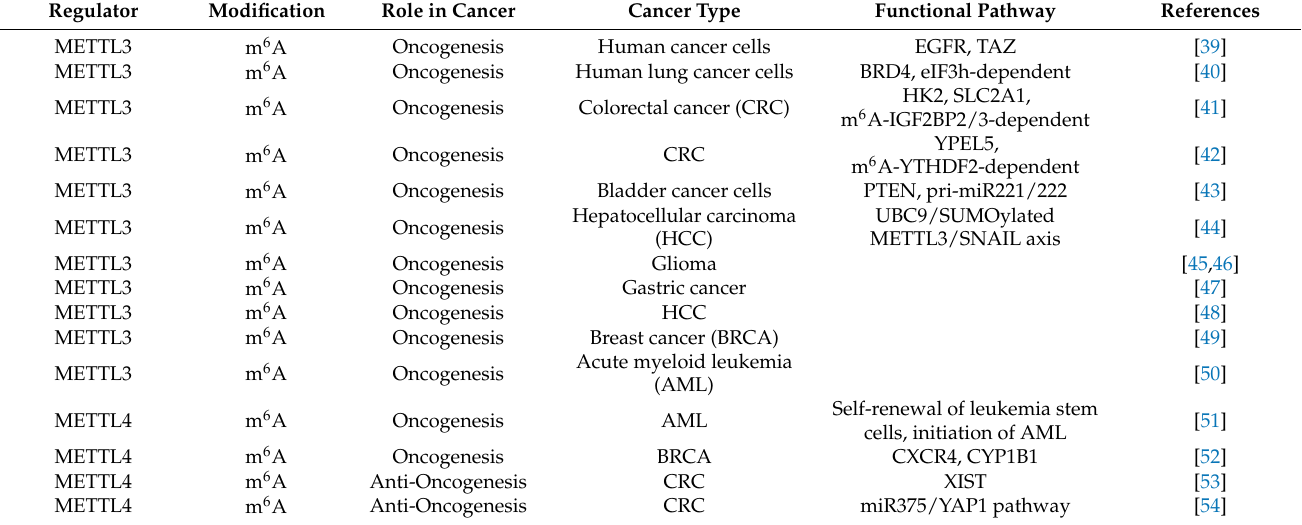
Table 2. The emerging roles of methyladenosine modification in